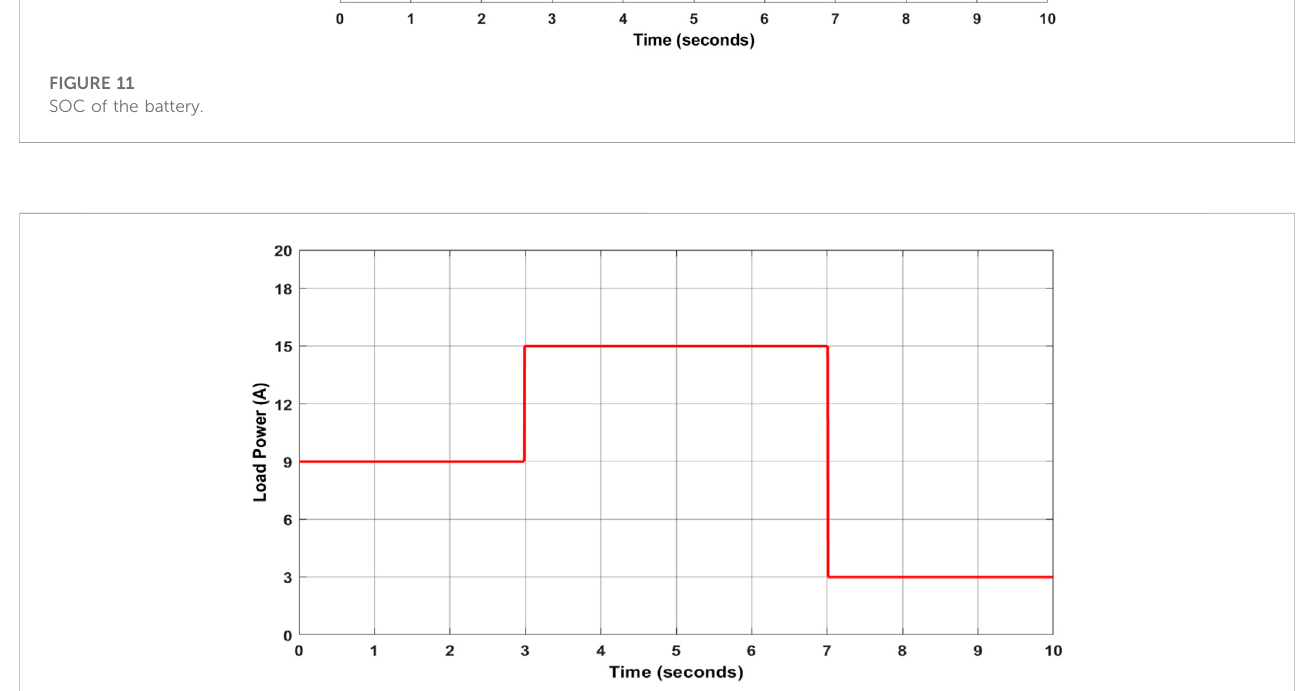
FIGURE 12 The suggested load pro fi